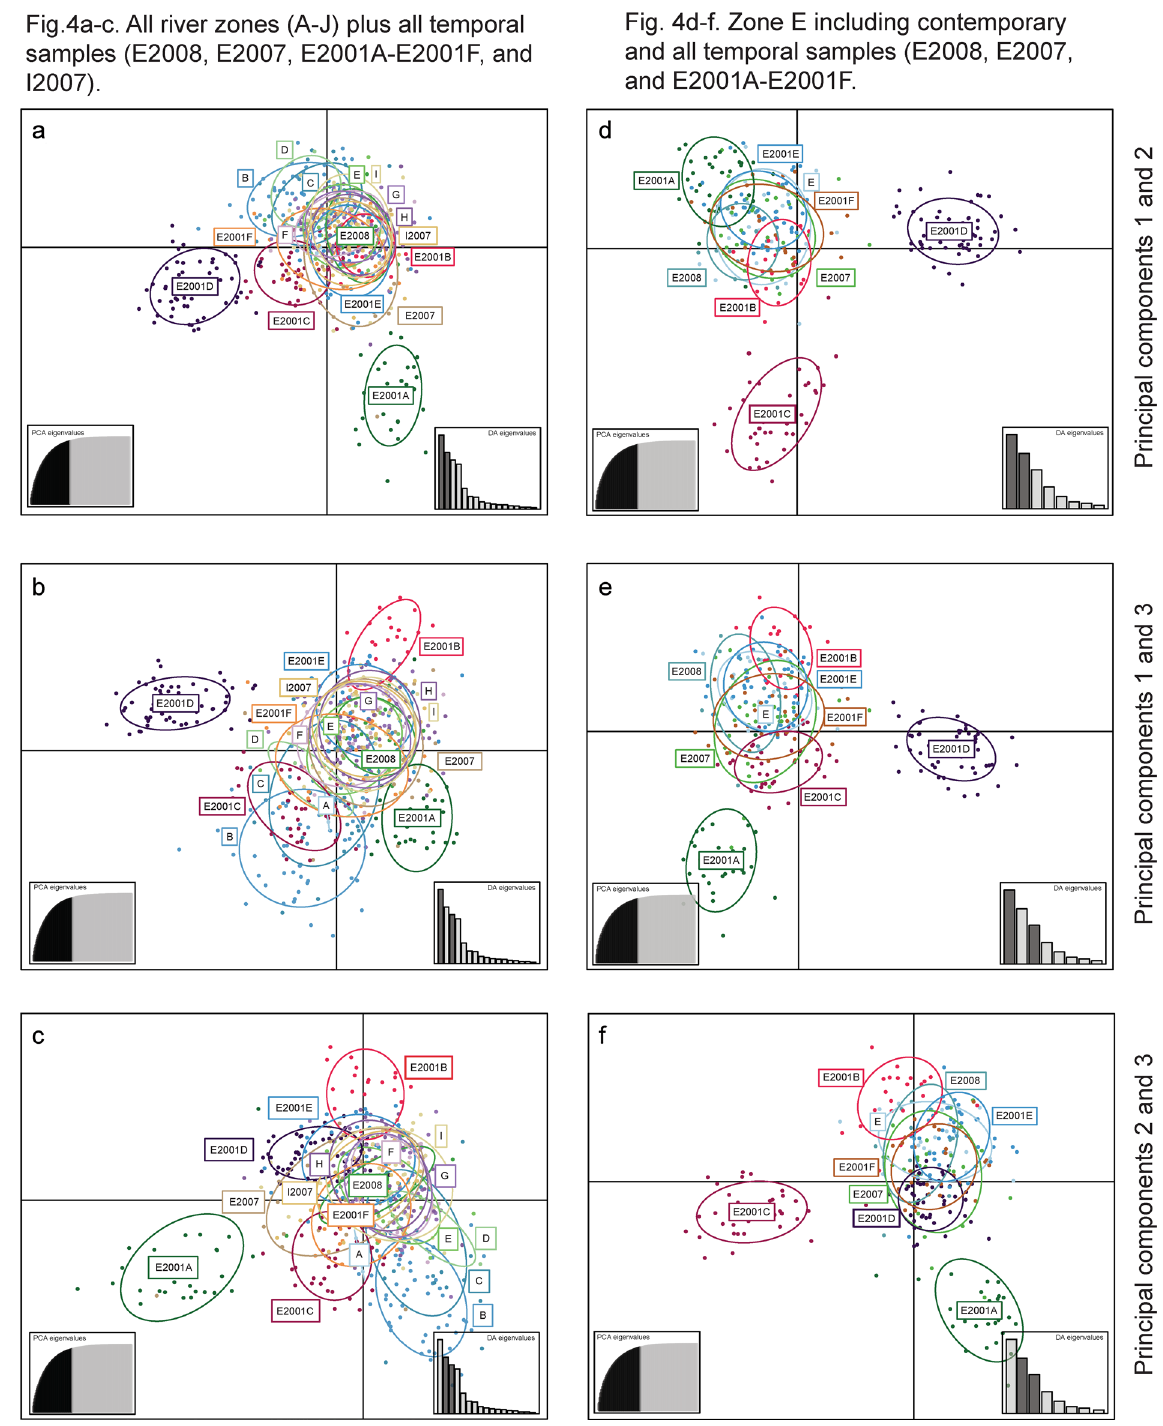
Figure 4. Discriminant analysis of principal components (DAPC) scatter plots based on 16 STR-markers and all individuals for brown trout ( Salmo trutta ). (a–c) DAPC scatter plots for all investigated river zones (i.e.,